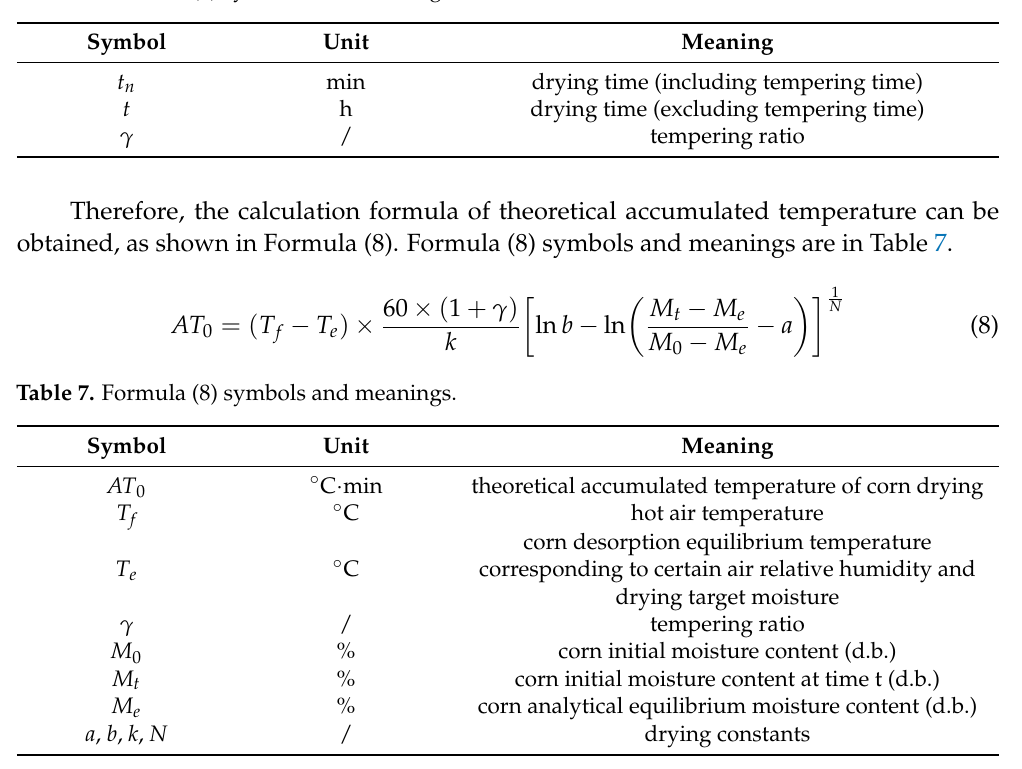
Table 6. Formula (7) symbols and meanings.